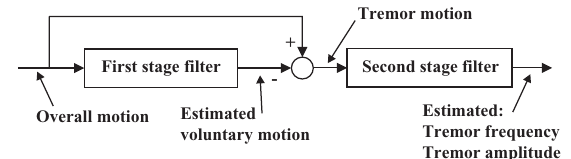
Figure 2 Two-stages of tremor modelling: first, the low frequency content voluntary motion is estimated, second, the voluntary motion estimation is subtracted from the original motion, eventually, tremor frequency and amplitude are determined.